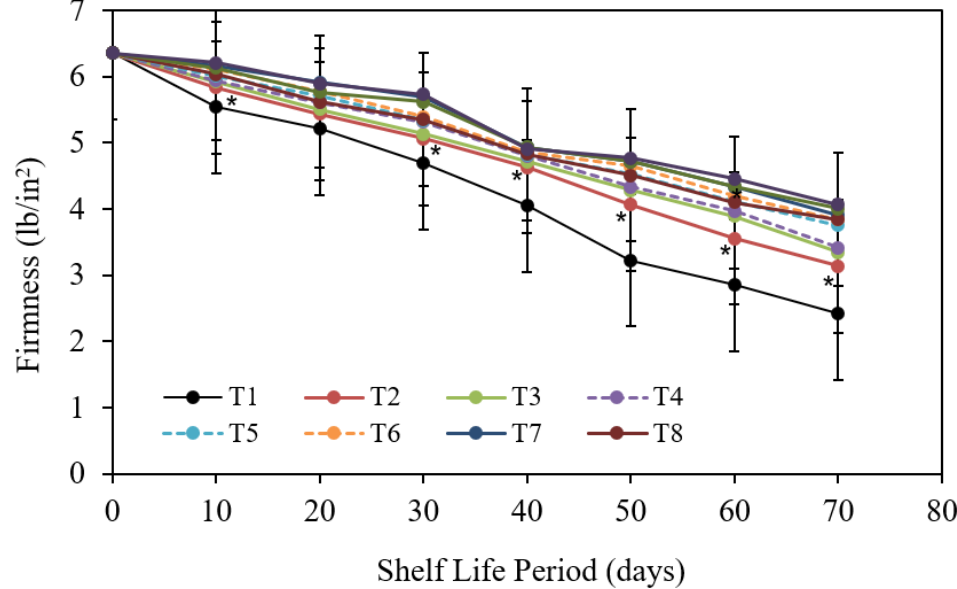
Figure 6. The impact of pre-harvest chitosan, chitosan nanoparticle and CaCl 2 foliar spray treatments on firmness of Barhi date fruits under cold storing for 70 d. Note that * sign denotes the significant differences between the control and edible coatings treatments, and T1, T2, T3, T4, T5, T6, T7, T8, T9, and T10 are water (control), 1 g/L chitosan, 2 g/L chitosan, 3 g/L chitosan, 1 g/L chitosan nanoparticles, 2 g/L chitosan nanoparticles, 3 g/L chitosan nanoparticles treatments, respectively.